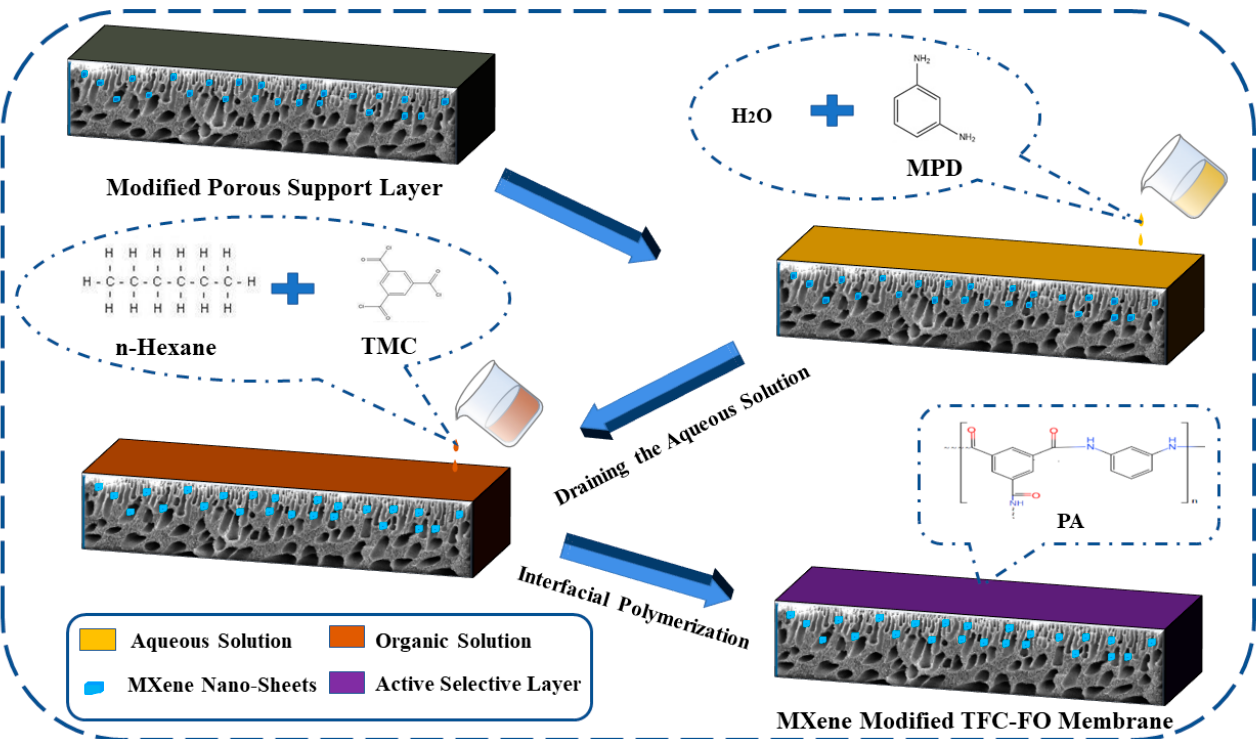
Figure 2. The active selective layer preparation by the interfacial polymerization reaction.